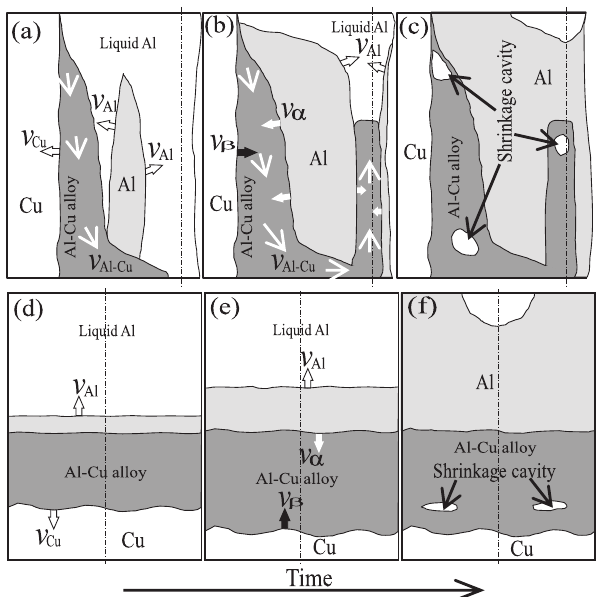
Figure 10: Schematic plan of solid Cu dissolution, solidification process of the transition layer and the shrinkage cavities formation: (a) – (c) vertical pouring; and (d) – (f) horizontal pouring. v – the growth rate of pure aluminum; v α Al (Al); v β – the growth of β